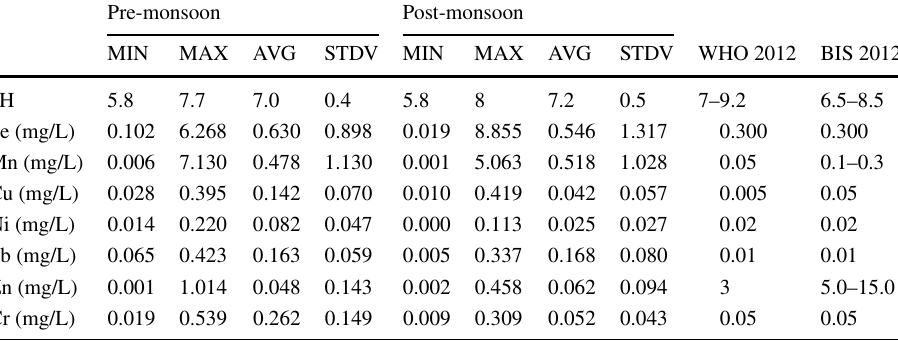
Table 1 Analytical results of trace metals in the study region for both pre-monsoon and post- monsoon